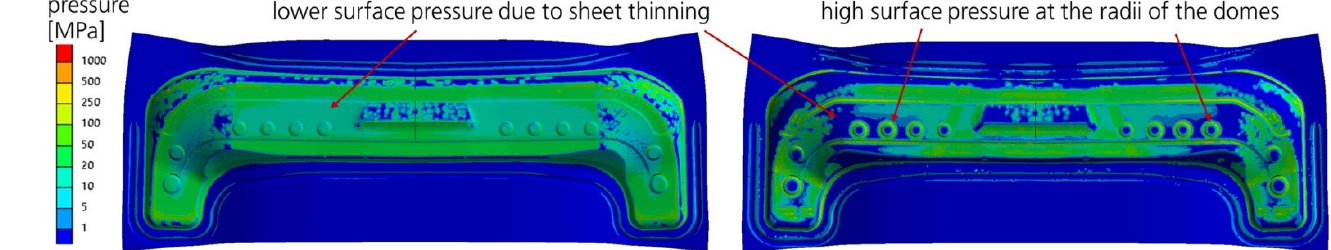
Eng. Proc. 2022 , 26 , 9